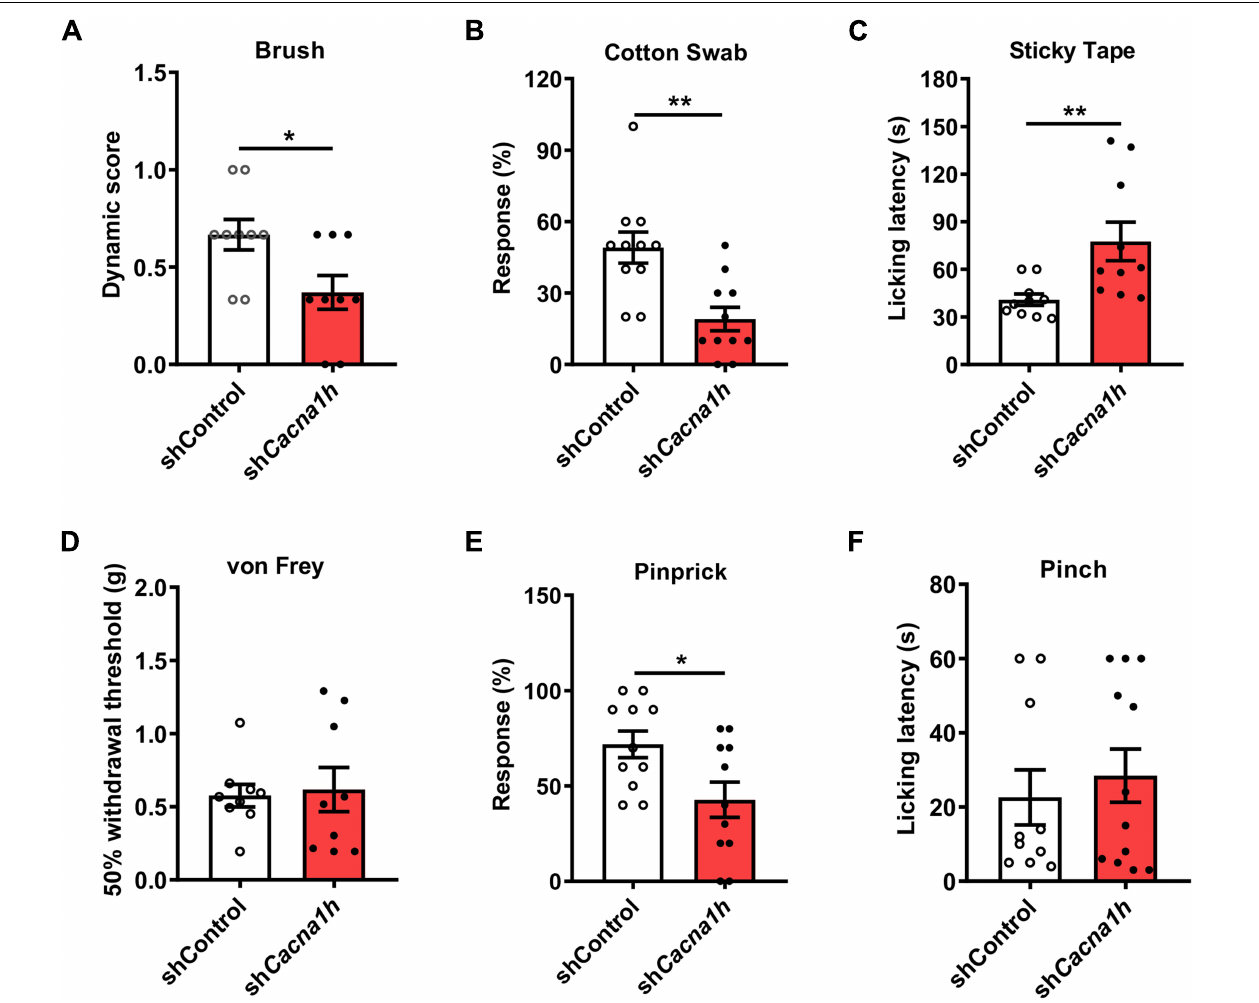
FIGURE 4 | Knockdown of Cacna1h in spinal SOM + neurons decreases the response to light touch and noxious mechanical stimulation in naïve mice. (A–C) Behavioral tests of the tactile sensation. Decreased the response to brush stimulation (A) and “pulled out” cotton swabs (B) , and increased licking latency to sticky tape (C) were observed after Cacna1h knockdown in spinal SOM + neurons. (D) The 50% withdrawal threshold to von Frey filament stimulation was unaffected by Cacna1h knockdown in spinal SOM + neurons. (E) The percentage of response to pinprick stimulation was reduced after Cacna1h knockdown in spinal SOM + neurons. * P < 0.05, Student’s unpaired t -test. (F) The licking latency to pinch stimulation was not affected by Cacna1h knockdown in spinal SOM + neurons. * P < 0.05, ** P < 0.01, Student’s unpaired t